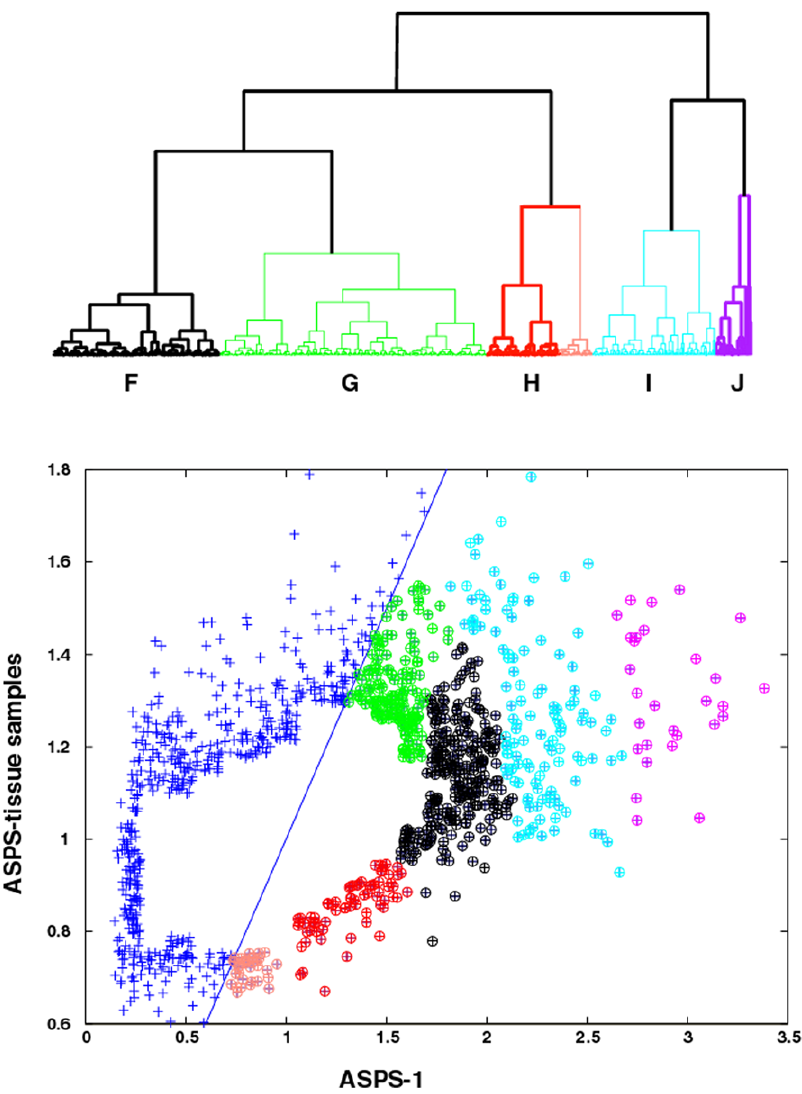
Figure 4. Top Panel, dendrogram for ASPS-1 gene expression. Clades are colored to identify samples associated with five meta-clade memberships (DEND meta-clades F-J). DEND meta-clade members with gene expressions lower than their universal RNA are highlighted in pink. Bottom Panel, ASPS-tissue versus ASPS-1 scatter plot where meta-clade memberships are color-coded to match the dendrogram displayed in the top panel.